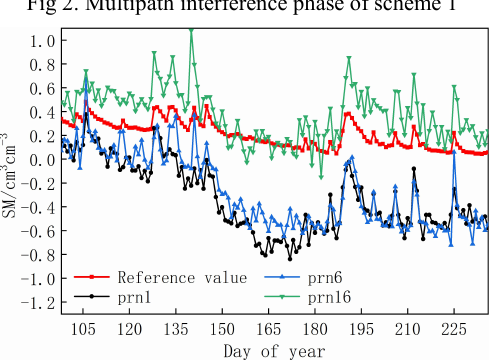
Fig 2. Multipath interference phase of scheme 1